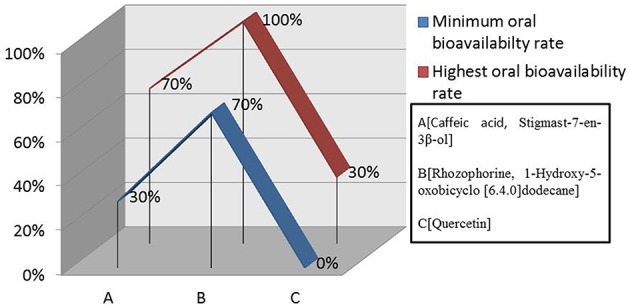
Oral bioavailability rate of compounds. Rhizophorine and 1-Hydroxy-5-oxobicyclo [6.4.0] dodecane indicated higher oral bioavailability rate (70–100%) than the other plant medicinal drug compounds.